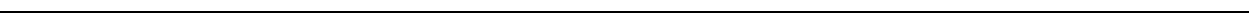
Fig. 3 Elimination of PKD1 activity enhances neuronal death in vitro and in vivo. a (Left panels) Representative confocal microscopy images of DAPI and MAP2 staining of primary neurons treated for 1 h with CRT (10 μ M) or vehicle (DMSO) followed by 4 h of NMDA. (Right panel) Percentage of these neurons bearing condensed nuclei relative to neurons treated 4 h with NMDA ( n = 120 – 150 neurons per condition; n = 3 independent experiments). b Neuronal viability measured by MTT assays after treatment with CRT and NMDA as above, relative to untreated neurons (triplicates per condition, n = 5 independent experiments). c PKD and NSE (loading control) immunoblot analysis and d confocal microscope images of MAP2 and DAPI staining of cortical neurons transduced with lentivirus encoding shC, shPKD1a, or shPKD1b. ( d , right panel) Quanti fi cation of MAP2+ cells relative to shC-transduced cultures ( n = 70 – 200 neurons per condition; n = 3 independent experiments). e shC- or shPKD1b-transduced neuronal cultures were treated with NMDA for the indicated times and viability was evaluated by MTT assays. Data are expressed relative to shC-transduced untreated neurons (triplicates per condition, n = 4 independent experiments). f PKD (left panels) and p-PKD(S916) (right panels) DAB immunostaining in cortex sections from PKD1 fl oxed and PKD1 KO mice. Representative images and zoom-boxed regions are also shown. g PKD1 fl oxed and PKD1 KO mice were subjected to 60 min of MCAO. Representative images of (left panels) Nissl-stained coronal brain sections and (middle panels) coronal T2-weighted MRI images obtained from the same animals 24 h after reperfusion. (Right panel) quanti fi cation of the infarct volume (mm 3 ) in PKD1 KO ( n = 10) and PKD1 fl oxed mice ( n = 7). Yellow dotted lines mark the ischemia boundary. h Flow cytometry analysis of DHE staining in PKD1 fl oxed and PKD1 KO cultured neurons unstimulated or after NMDARs overstimulation for 1 h. Data are shown relative to untreated PKD1 fl oxed neurons ( n = 4 independent experiments). i Representative confocal microscopy images of MDA-, NeuN-, and DAPI-stained cortical penumbra area from MCAO-operated mice and the equivalent cortical region of sham-operated animals in PKD1 fl oxed and PKD1 KO. ( i , right panel) Percentage of NeuN+ cells containing MDA staining in penumbra zone of MCAO-operated mice (I) compared to the equivalent cortical region of sham-operated animals (S) expressed relative to that of sham PKD1 fl oxed ( n = 150 neurons; n = 2 sections per animal, n = 3 animals per condition). For quanti fi cations, mean ± s.e.m. were derived from the indicated number of independent experiments. * P < 0.05, ** P < 0.01, *** P < 0.001; two-tailed unpaired Student's t test ( a – f , h – i ) and two-tailed unpaired Student's t test with Welch's correction ( g